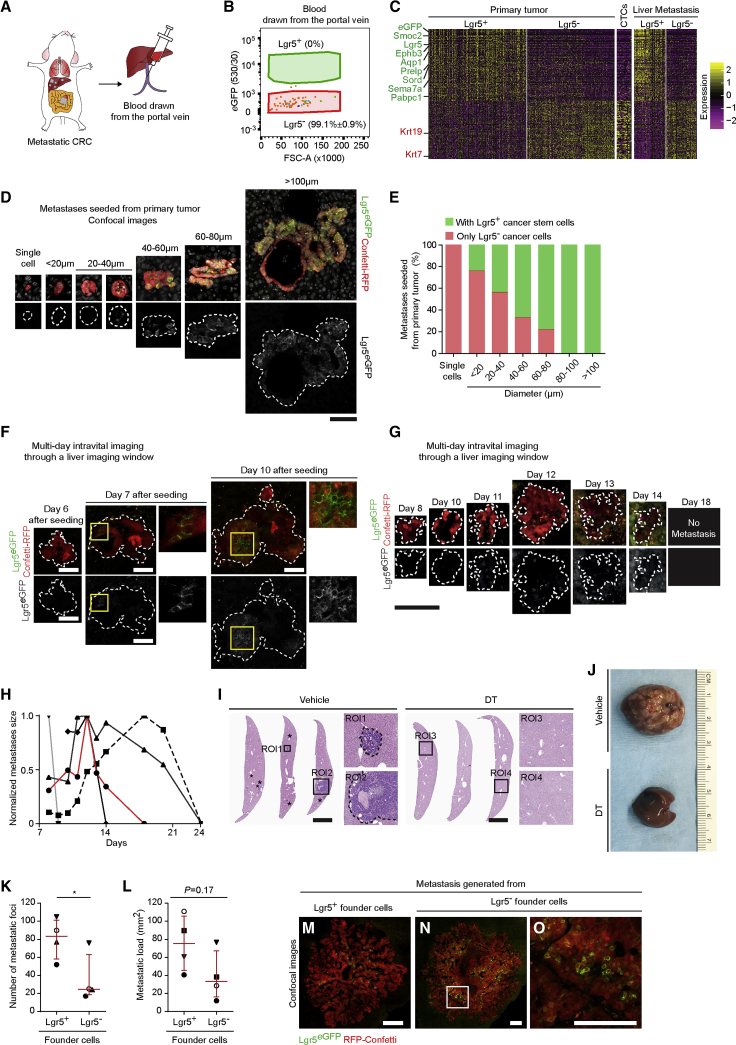
Lgr5− Cancer Cells Are the Disseminating Cells in CRC(A) Experimental setup: mice bearing metastatic CRC were used to sample blood from the portal vein. Blood was analyzed using FACS for the presence of circulating tumor cells.(B) Cumulative FACS profile of circulating Lgr5+ CSCs and Lgr5− cancer cells (n = 4). The color coding links individual circulating tumor cells to the corresponding blood sample in Figure S3B.(C) Heatmap of differentially expressed genes in Lgr5+ and Lgr5− cancer cells isolated from primary tumors, CTCs, and liver metastasis. Genes marked with green are known to be upregulated in intestinal stem cells; genes marked in red indicate known intestinal differentiated cell markers.(D) Representative confocal images of spontaneous liver metastases grouped per diameter range. Dashed lines highlight the metastasis edges. Scale bar, 100 μm.(E) Metastases are subdivided in lesions composed of only Lgr5− cancer cells (red) or lesions containing Lgr5+ CSCs (green) and grouped per diameter range (the analysis includes 132 metastatic lesions, n = 6).(F) Intravital multi-day imaging of liver metastases hatching from Lgr5− cancer cells. Dashed lines highlight metastasis edges. Yellow boxed areas are enlarged next to the corresponding panels. Scale bars, 50 μm.(G) Representative images of a liver metastasis followed overtime by intravital imaging demonstrating growth and regression upon depletion of Lgr5+ CSCs via diphtheria toxin (DT) administration. Dashed lines highlight metastasis border. Scale bar, 100 μm.(H) Size of DT-treated metastatic lesions followed by intravital imaging (n = 5), normalized to the first time point. The red line represents the example shown in (G).(I) Representative histochemistry images of livers of mice subjected mesenteric vein injection of FACS-sorted Lgr5− cancer cells and treated with either vehicle or DT treatment for 4 weeks. ROI, region of interest. Asterisks indicate metastatic foci; dashed lines highlight metastasis edges. Boxed areas are enlarged next to the corresponding overview images. Scale bars, 500 μm.(J) Representative examples of livers of mice of mice subjected mesenteric vein injection of CRC Lgr5eGFP and treated with either vehicle or DT treatment for 4 weeks.(K) Number of metastatic foci derived from mesenteric vein injection of Lgr5+ CSCs or Lgr5− cancer cells.(L) Metastatic load upon injection of Lgr5+ CSCs or Lgr5− cancer cells. Similar shapes represent paired experiments (n = 4). Data are presented as median with interquartile range; p values were calculated using the paired t test (∗p < 0.05).(M–O) Representative examples of metastases generated from Lgr5+ CSCs (M) and Lgr5− cancer cells (N), boxed area enlarged in (O). Scale bars, 100 μm.